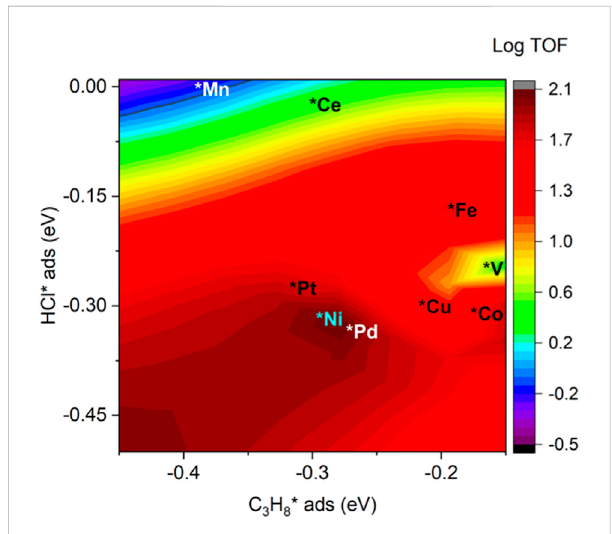
FIGURE 8 Relationship between TOF (C 3 H 8 conversion) and the adsorption energies of HCl and C 3 H 8